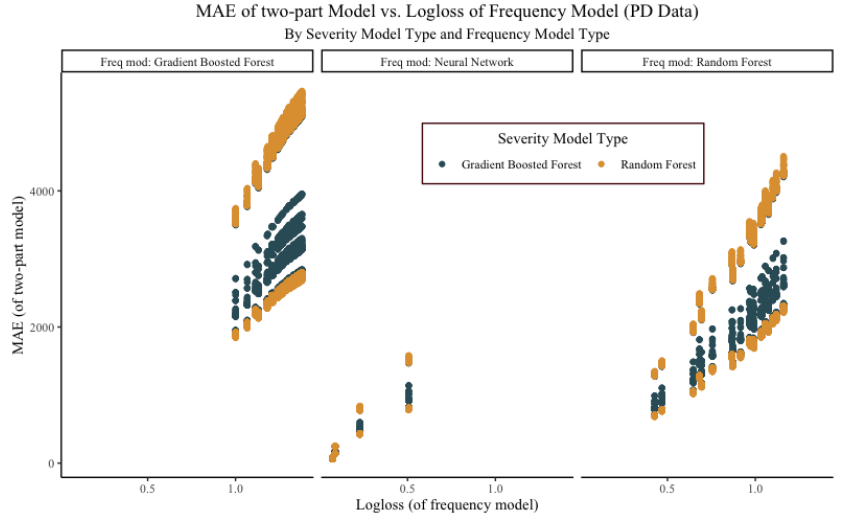
Figure 21. Comparison of the logloss of the frequency model part to the MAE of the overall two-part model for the PD data. MAE of the entire two-part model is shown on the y -axis while logloss of the frequency model is shown on the x -axis in order to illustrate how the logloss can affect the overall performance of the two-part model. Different types of frequency models are shown in each pane, while severity model types are shown by different colored